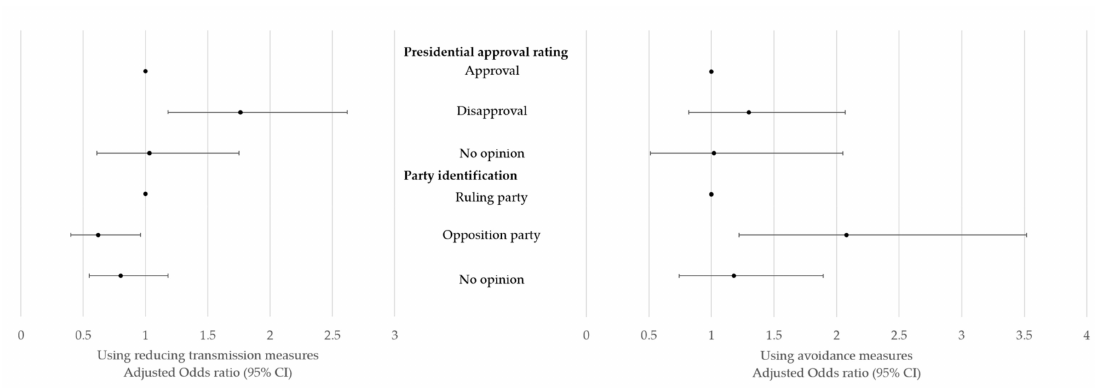
Figure 1. Adjusted odds ratios of nonpharmaceutical preventive behaviors according to political